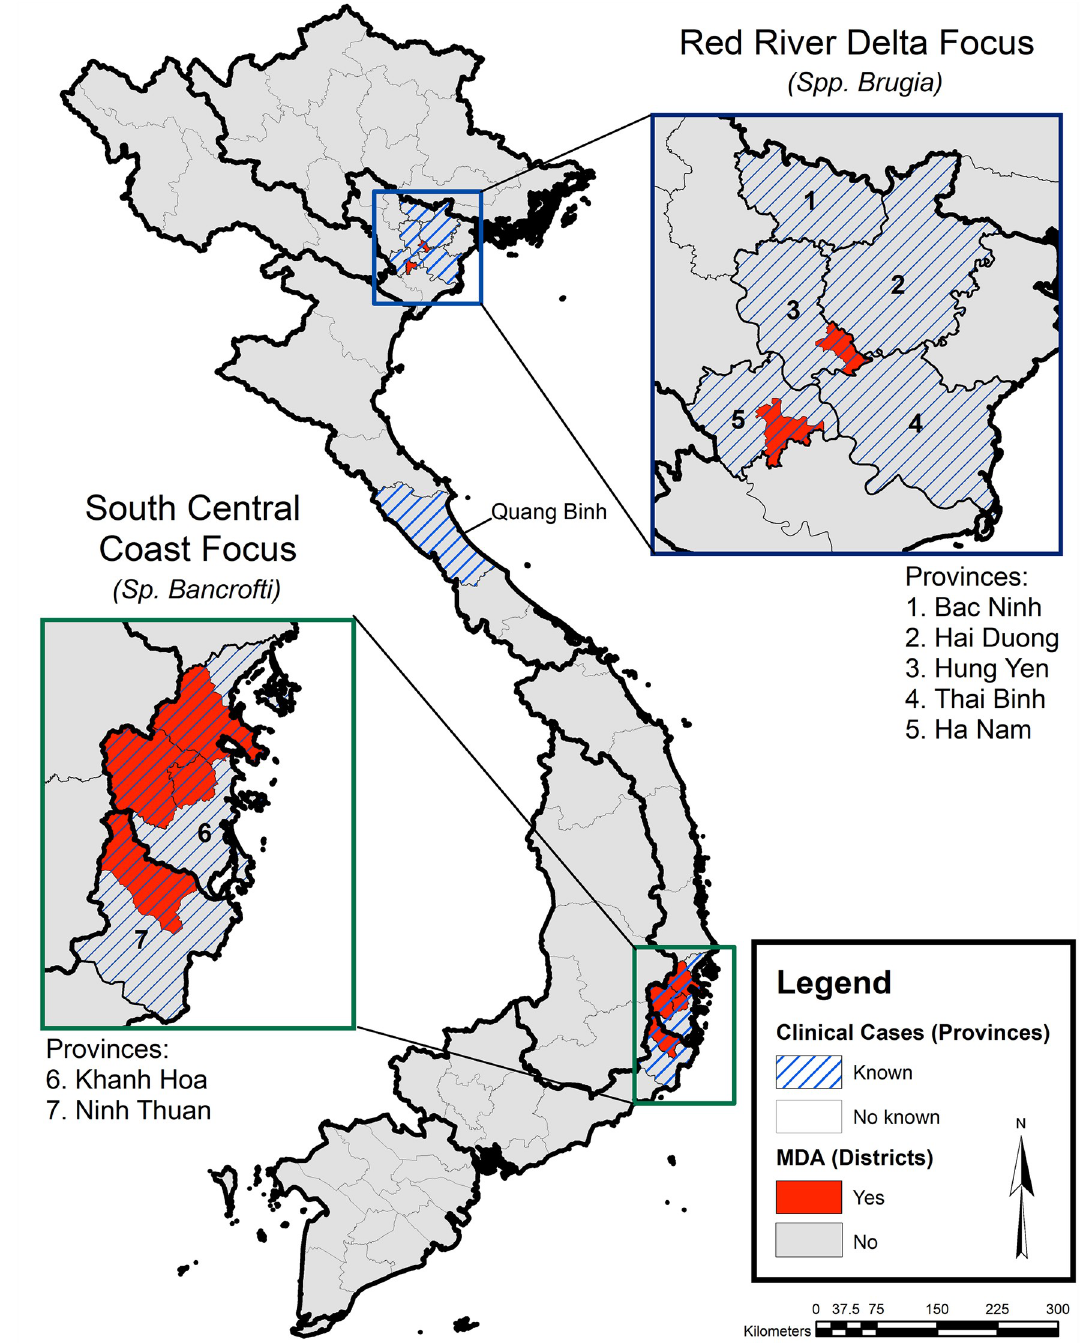
Fig 1. Map of lymphedema patient distribution (province level) and MDA implementation (district level) in Vietnam. Patient information is summarized at the province level in the RRD focus using CHS data collected during 2012 morbidity surveys and data collected during the 2005 MDA in the South Central Coast focus. Information was solicited from Quang Binh province (North Central region) prior to the 2016 DIP survey. The areas in red denote the six districts that conducted MDA in the GPELF era.